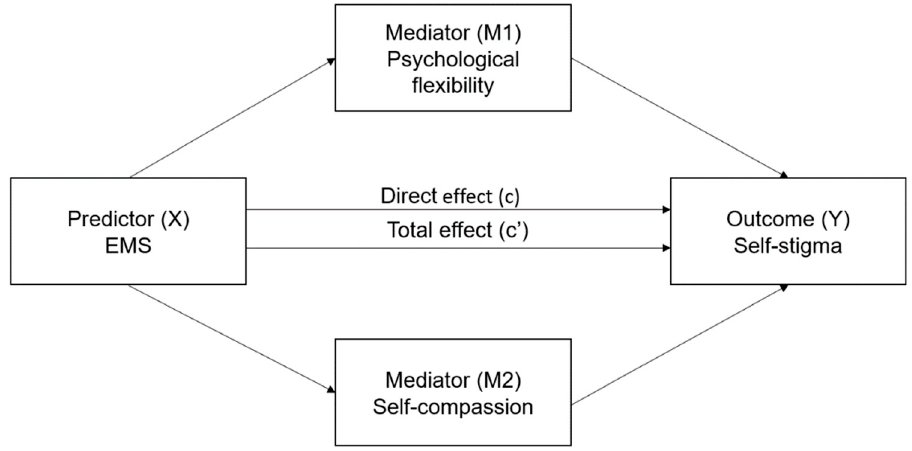
Figure 1. The parallel mediation model. Table 5. Two parallel bootstrapped mediation models testing whether the relationship between ei- ther Disconnection domain (X) of early maladaptive schemas (EMS) or Impaired Autonomy domain (X) of EMS, and self-stigma (Y) is mediated by Psychological Flexibility (M1) and/or Self-compassion (M2). Model & Effects